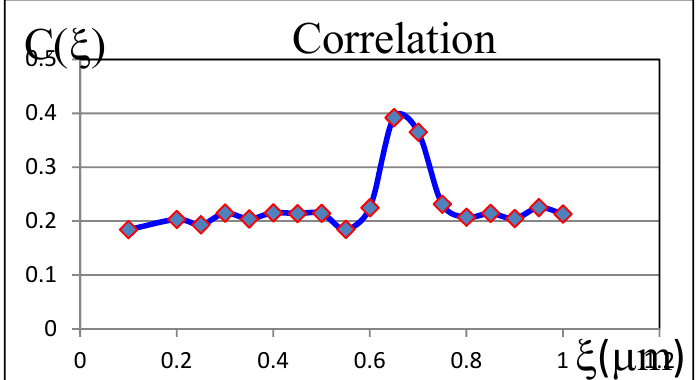
Figure 5. Speckle patterns corresponding to the maximum correlation. ( a ) First exposure for the laser beam (lb1) for an incidence of 45°. ( b ) Speckle field picture of the second beam (lb2) when the CCD camera is displaced by an amount correspond to a camera of 658 × 496 pixels (8.5 × 6.5 mm 2